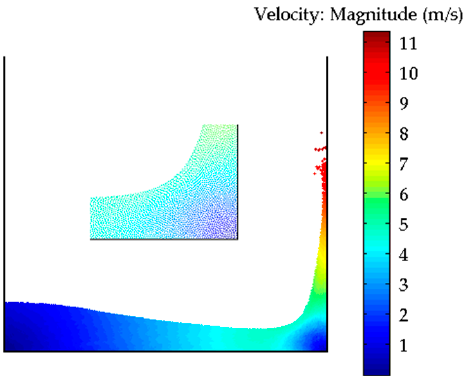
Figure 13. Velocity field in the SPH simulation (